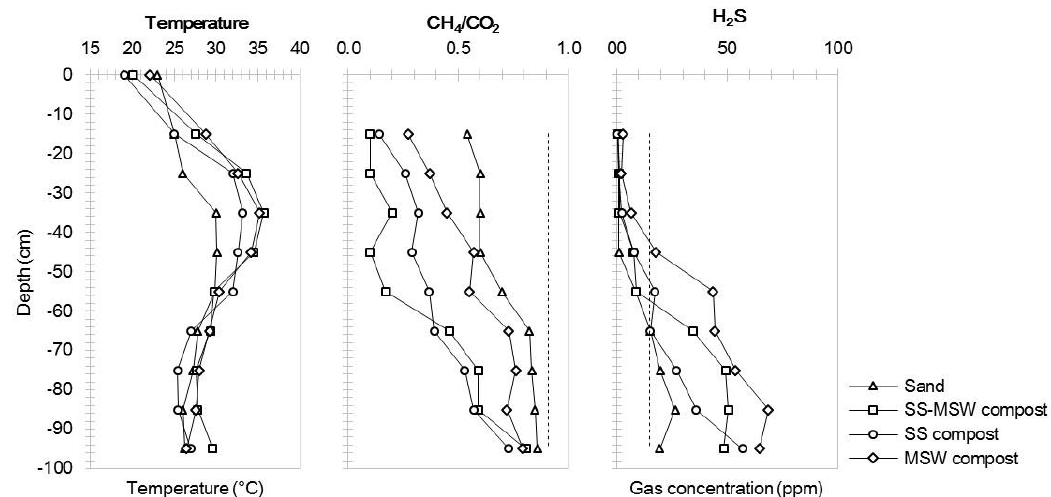
Figure 4. Average temperature, CH 4 / CO 2 ratio and H 2 S concentration profiles. Dotted lines represent the expected limits.